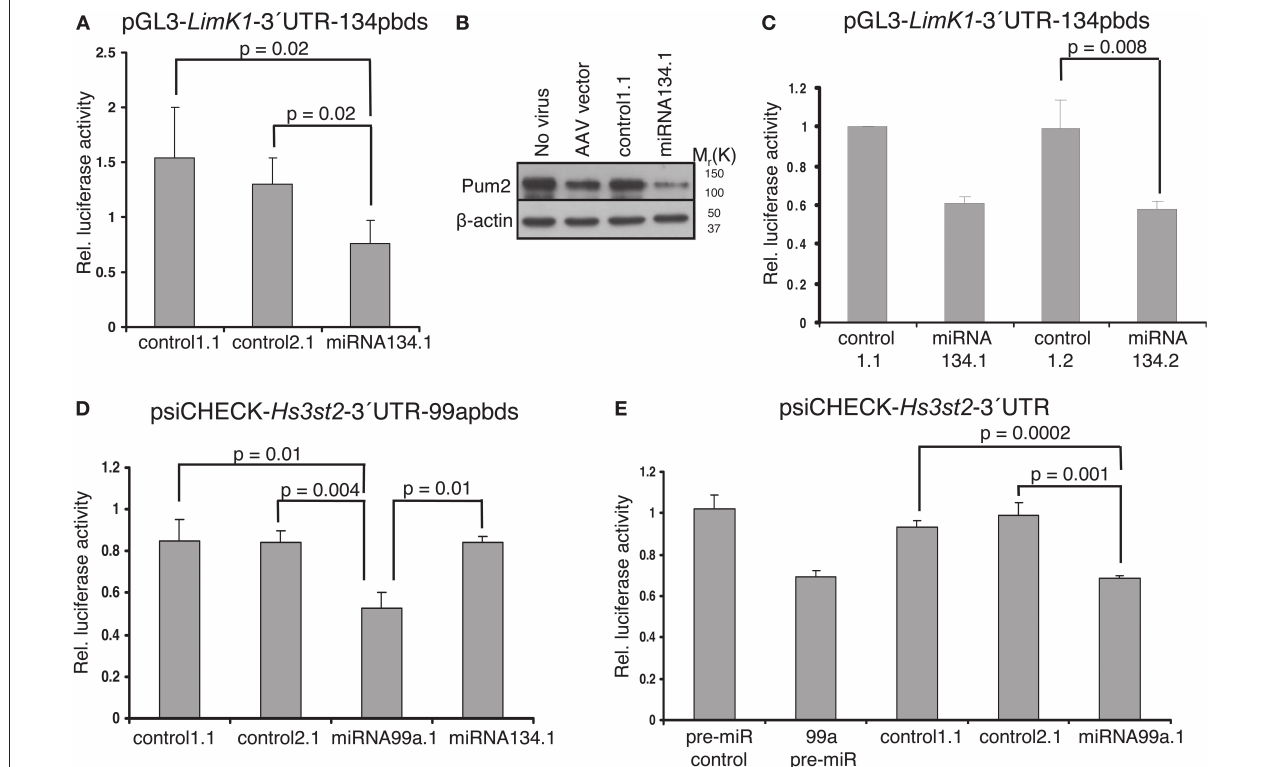
FIGURE 3 | Functionality of products expressed from miRNA134.1, 2 and miRNA99a.1. (A,C) Products of the miRNA134.1 (A) and miRNA134.2 (C) constructs regulate expression of a luciferase reporter construct carrying a miR-134 perfect binding site. The indicated plasmids (or AAV vector) were co-transfected along with the pGL3- LimK1 -3 ′ UTR-134pbds construct into primary cortical neurons for luciferase assay analysis (see Materials and Methods for details). Values are expressed relative to the internal Renilla luciferase activity and normalized to the activity of the luciferase reporter when co-transfected with (A) AAV vector and (C) control1.1, which both are arbitrarily set to 1. Results are shown as means + s.d. [ (A) : n = 4; (C) : n = 3]. Indicated p-values were calculated using Student ′ s t -test. (B) miR-134 expressed from the miRNA134.1 construct affects the Pum2 protein levels. 10–11 DIV hippocampal neurons were transduced with purifi ed rAAV carrying the indicated plasmids. Eight days later whole cell extracts were prepared and